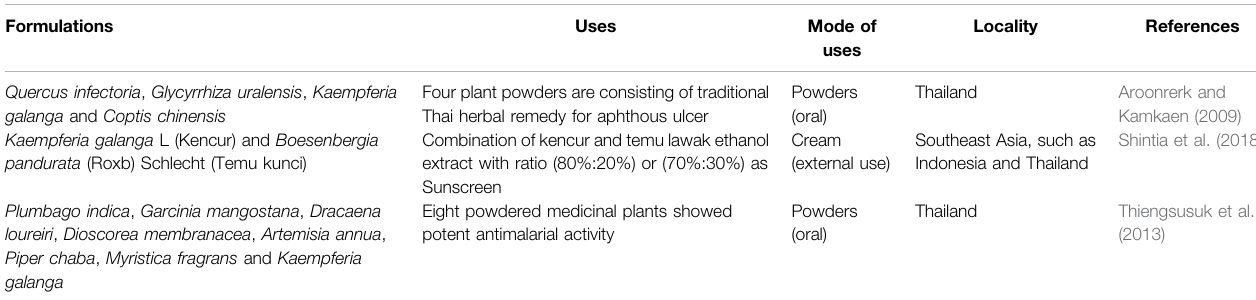
TABLE 2 | Classic prescriptions of K. galanga.